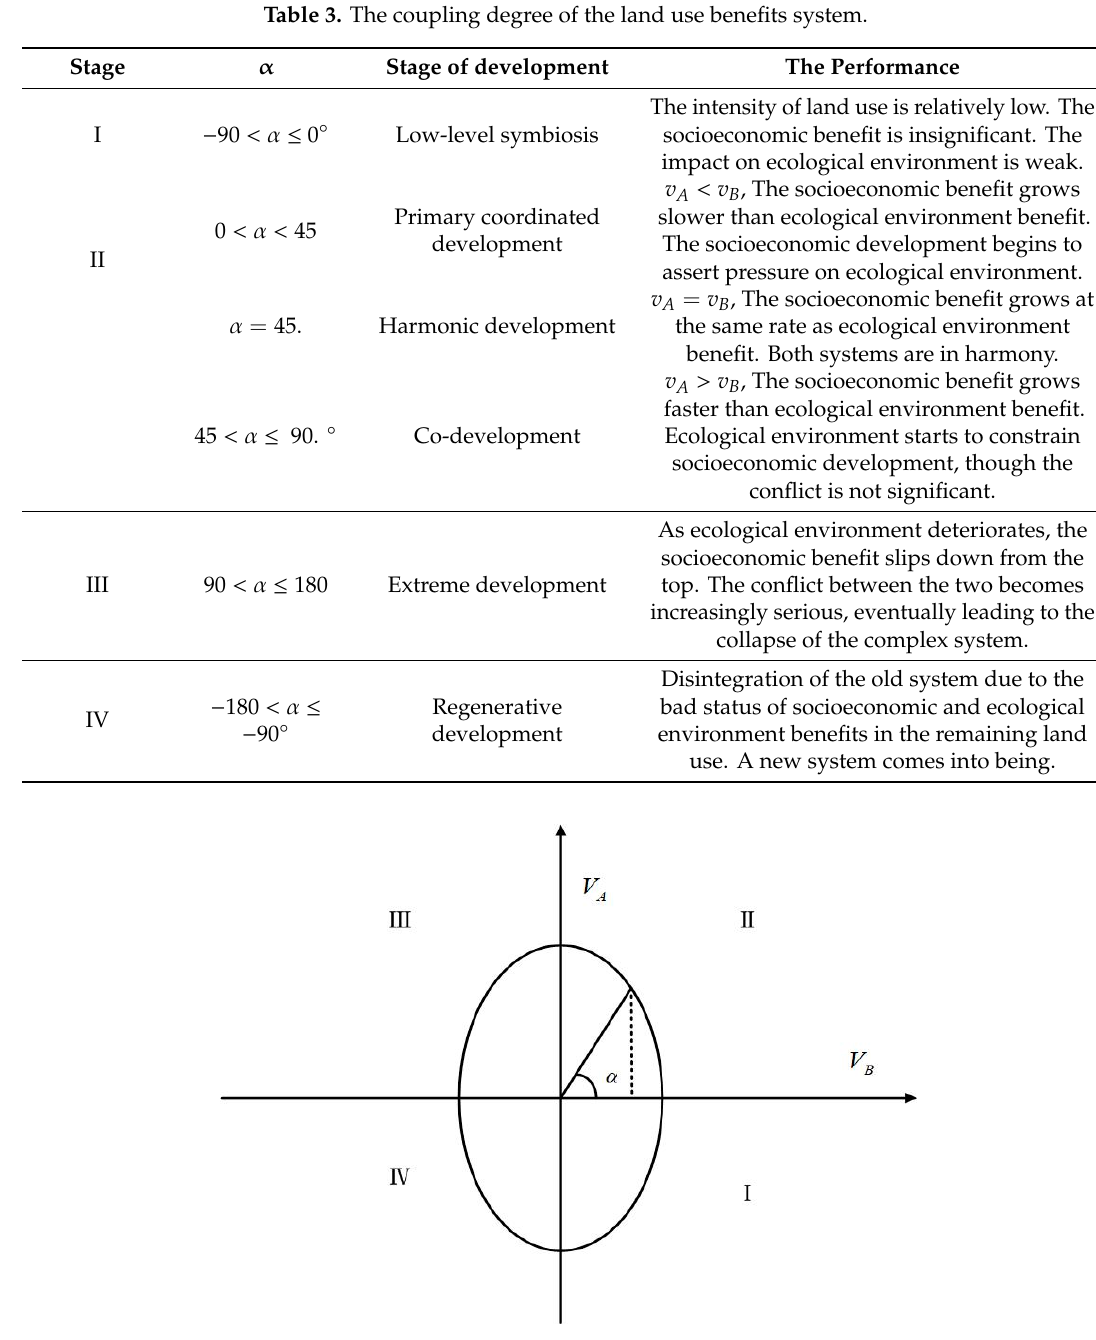
Figure 3. Process of coupling state of land use benefits system. Table 3. The coupling degree of the land use benefits system.